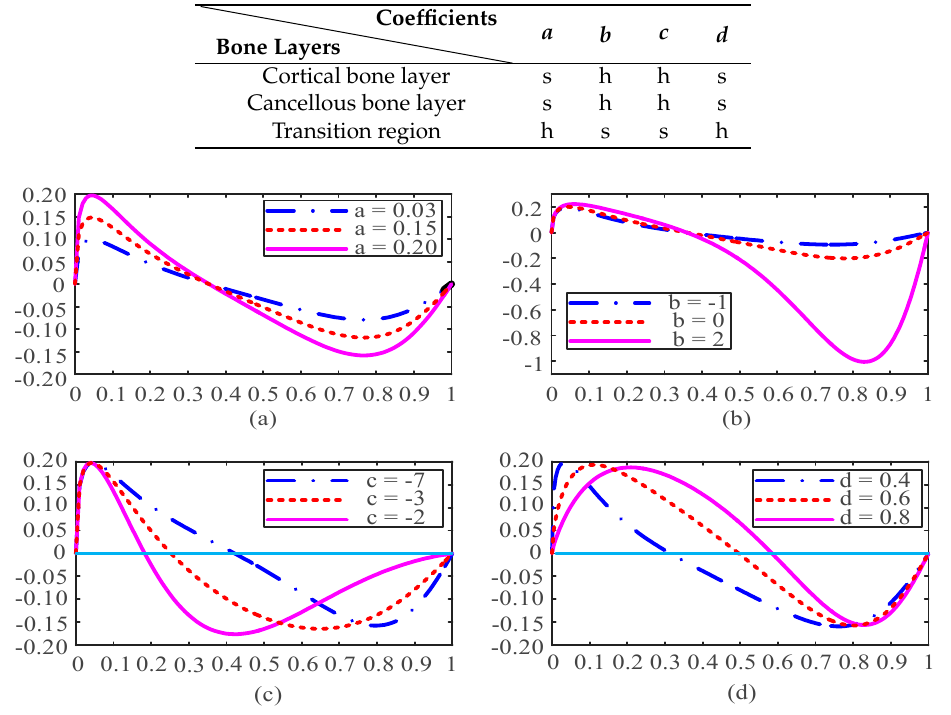
Table 2. The coefficients for different bone layers.